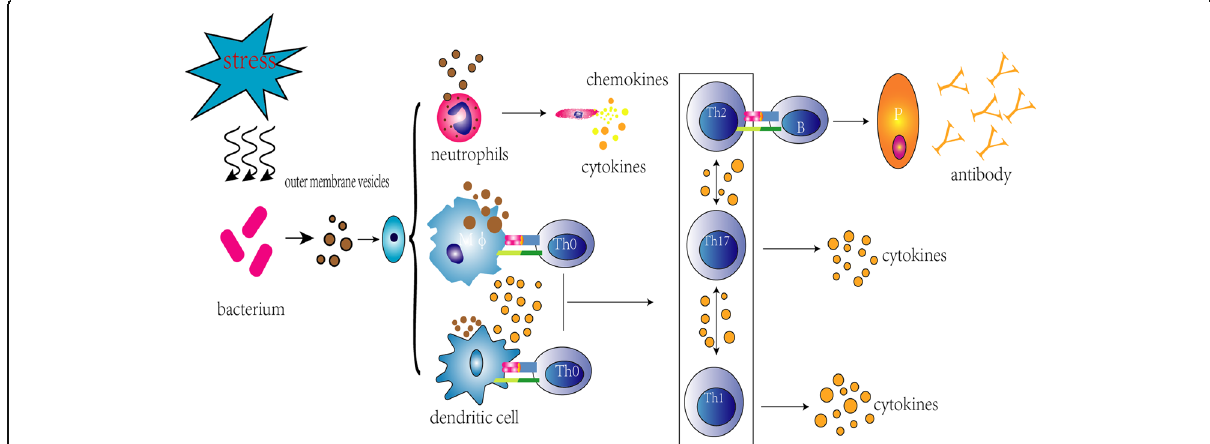
Fig. 2 Brief illustration about interactions involved in OMVs and main immune cells. Legend section: stress; bacterium; outer membrane vesicles; neutrophils; dendritic cells; chemokines; cytokines;